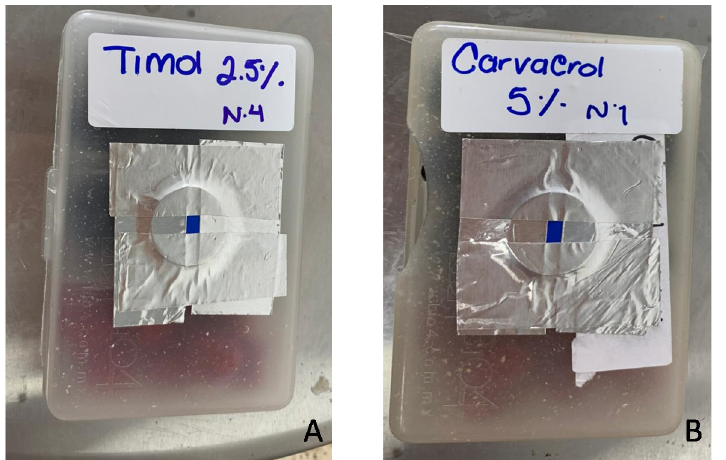
Figure 2. Boxes containing blackberries and raspberries adapted for headspace sampling. ( A ) PLA/ β -CD-thymol, 2.5% wt%; ( B ) PLA/ β -CD-carvacrol,